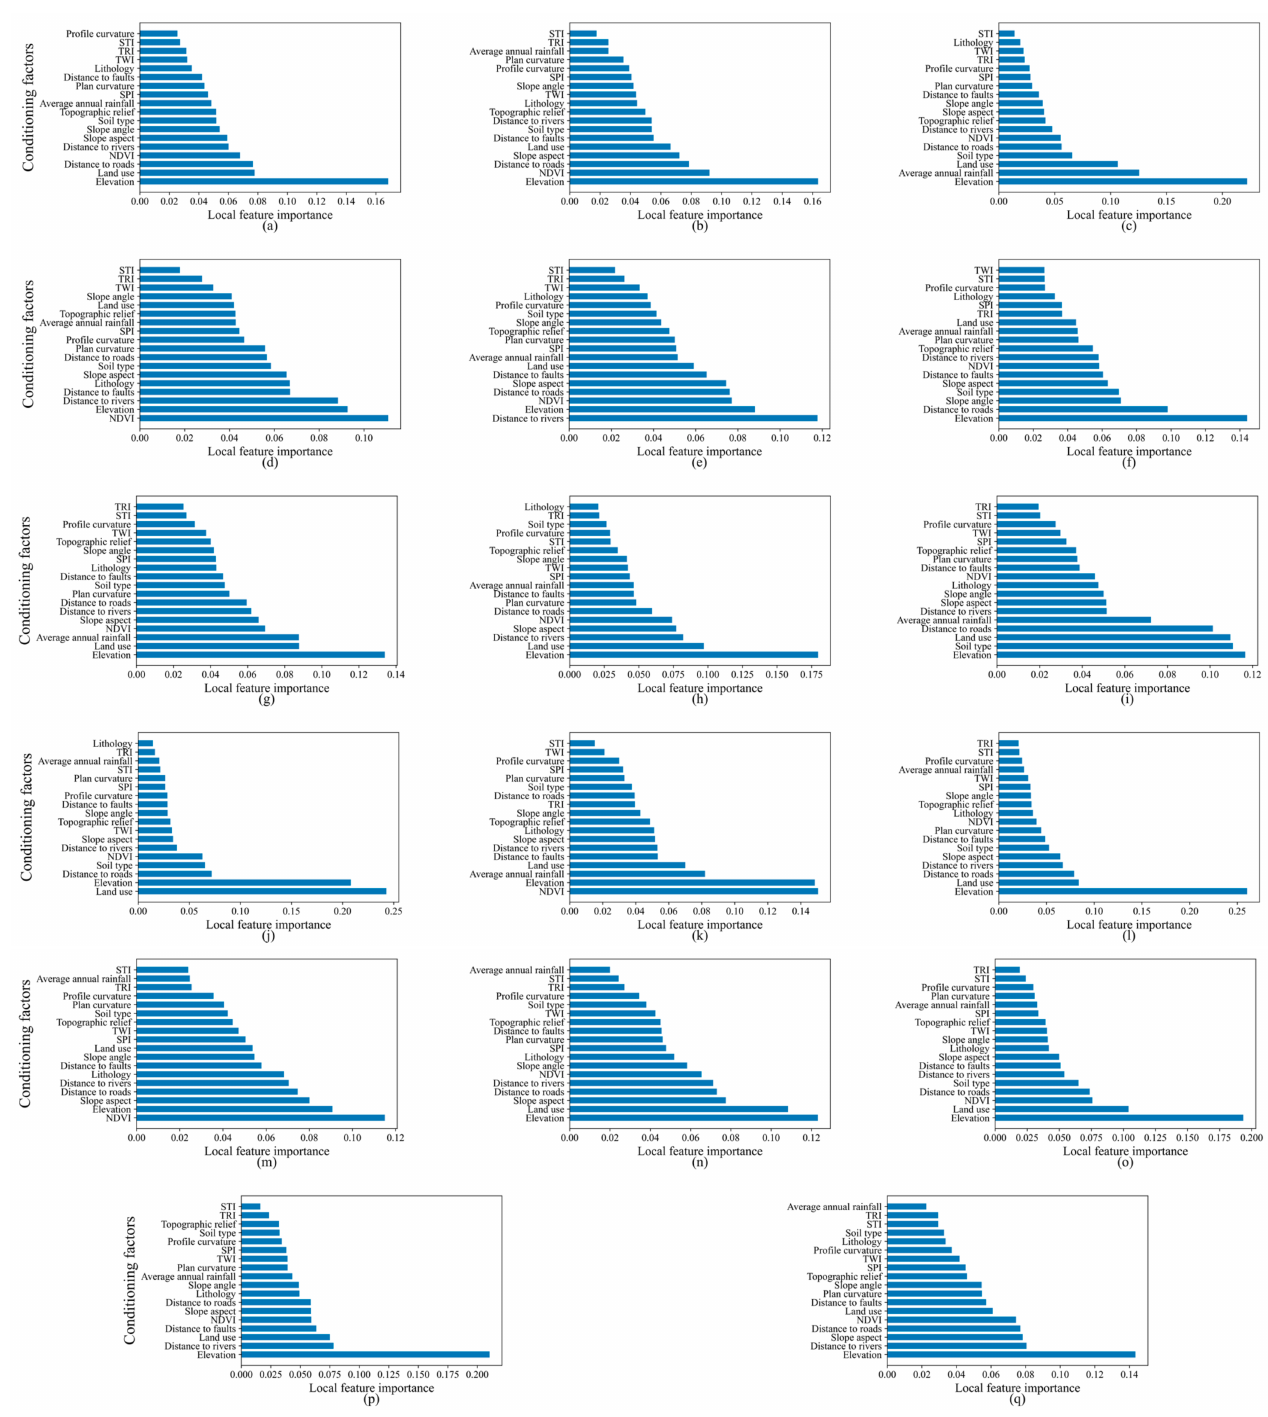
Figure 7. Local feature importance at the county level: ( a ) Butuo County; ( b ) Dechang County; ( c ) Ganluo County; ( d ) Huidong County; ( e ) Huili City; ( f ) Jinyang County; ( g ) Leibo County; ( h ) Meigu County; ( i ) Mianning County; ( j ) Muli County; ( k ) Ningnan County; ( l ) Puge County; ( m ) Xichang City; ( n ) Xide County; ( o ) Yanyuan County; ( p ) Yuexi County; ( q ) Zhaojue